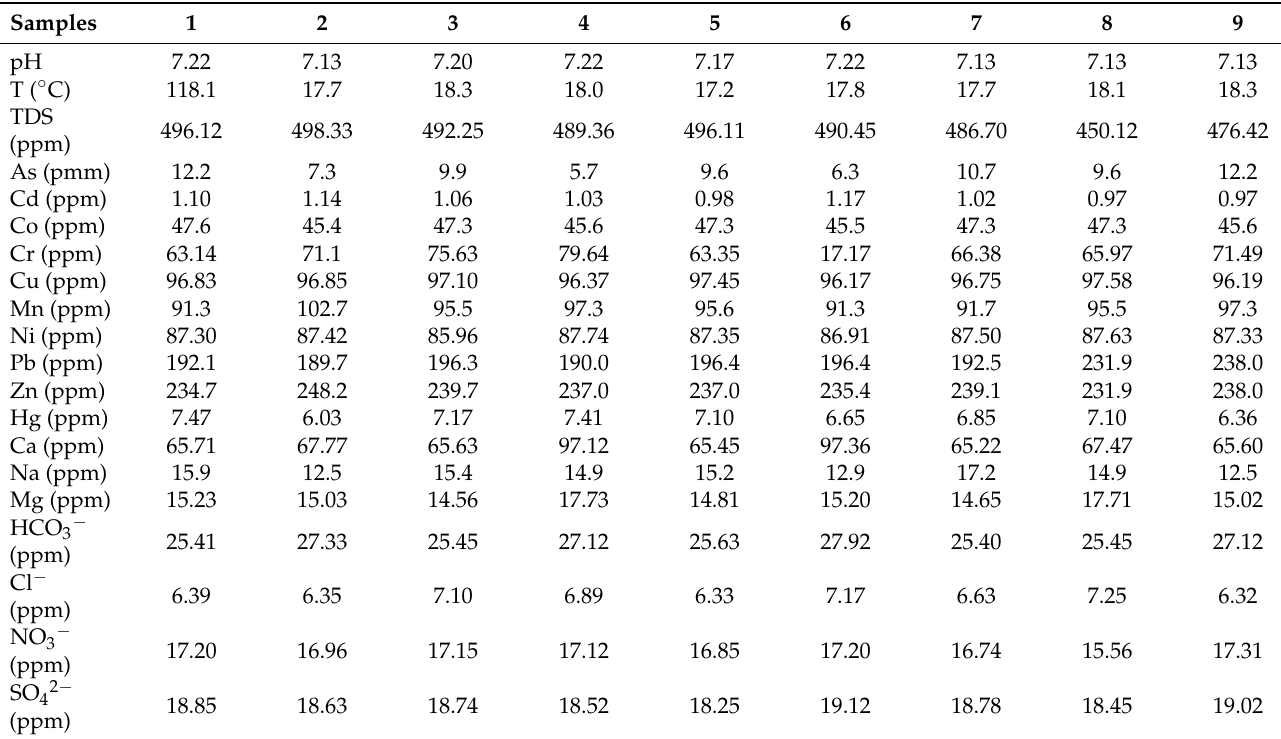
Table 1. Chemical composition of the Tabriz landfill